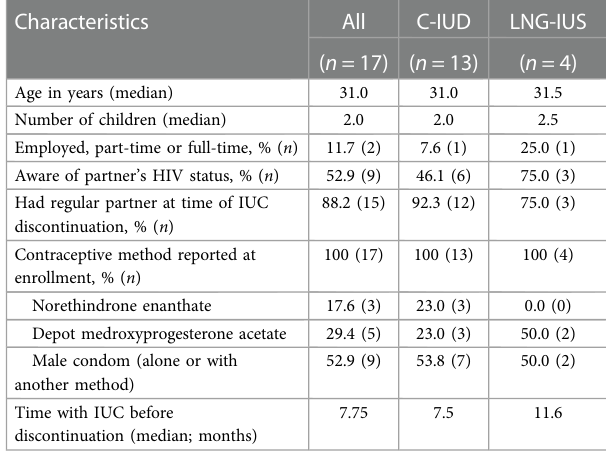
TABLE 1 In-depth interview participant characteristics & main reason for intrauterine contraceptive (IUC) discontinuation among women living with HIV participating in a clinical trial in Cape Town, South